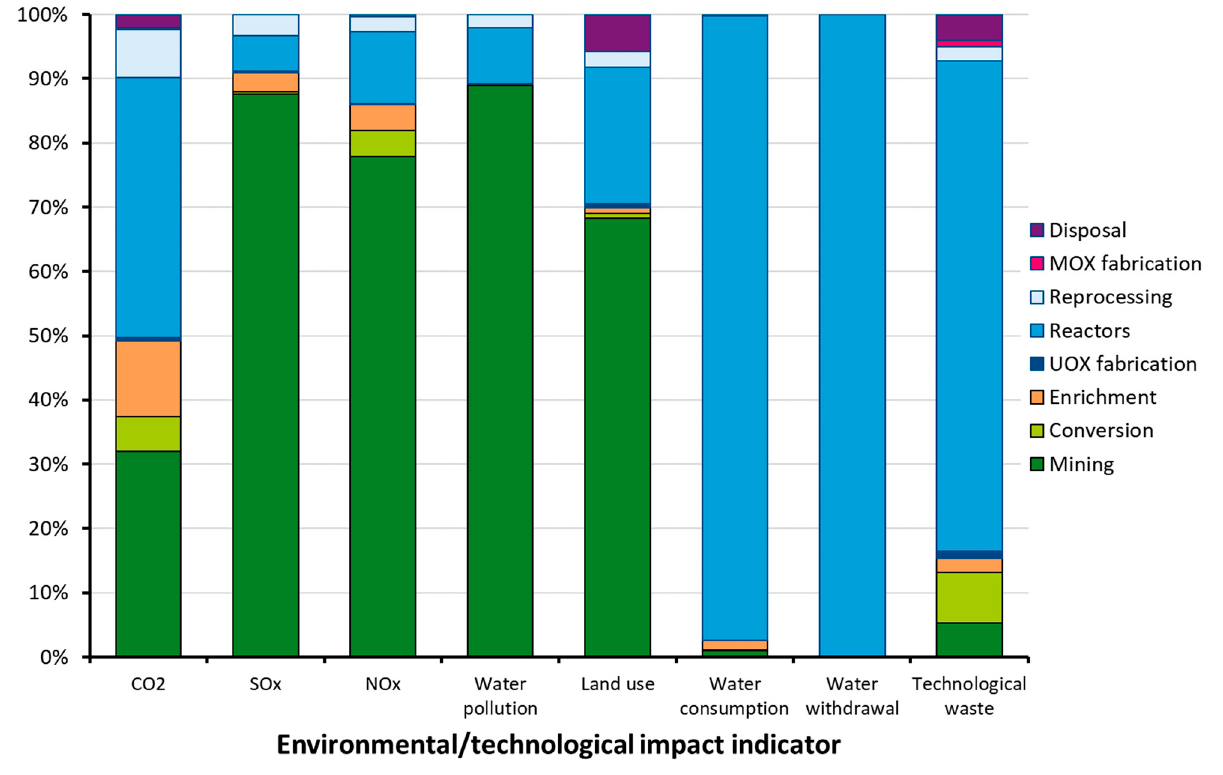
Figure 6. Relative contribution of each step of the fuel cycle to the environmental and technological impact indicators calculated with NELCAS for the French TTC. Redrawn from data in [50]. Comparisons of the actual French TTC to a hypothetical French OTC (calculated